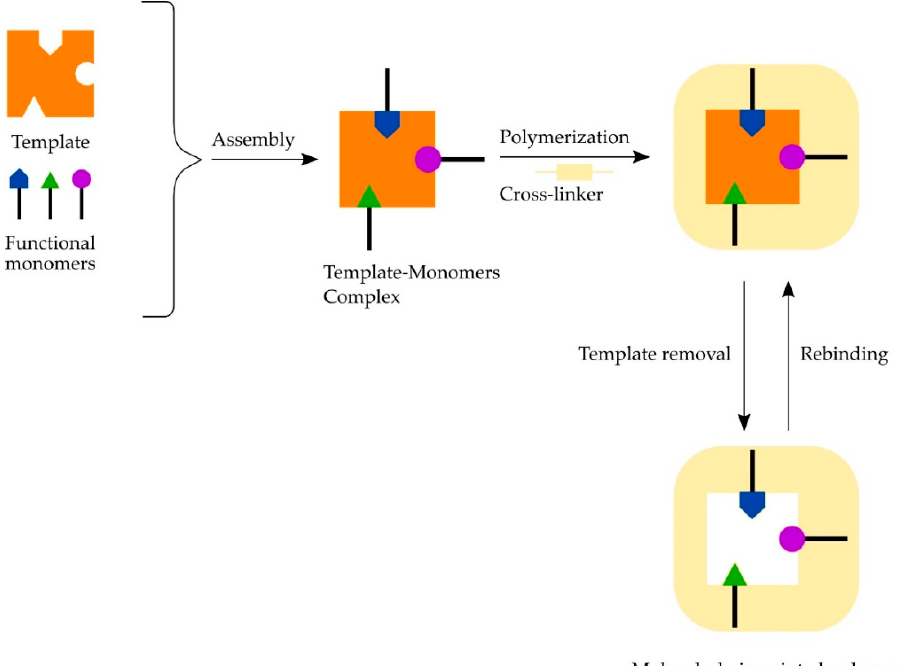
Figure 3. Scheme of molecularly imprinted polymer preparation.